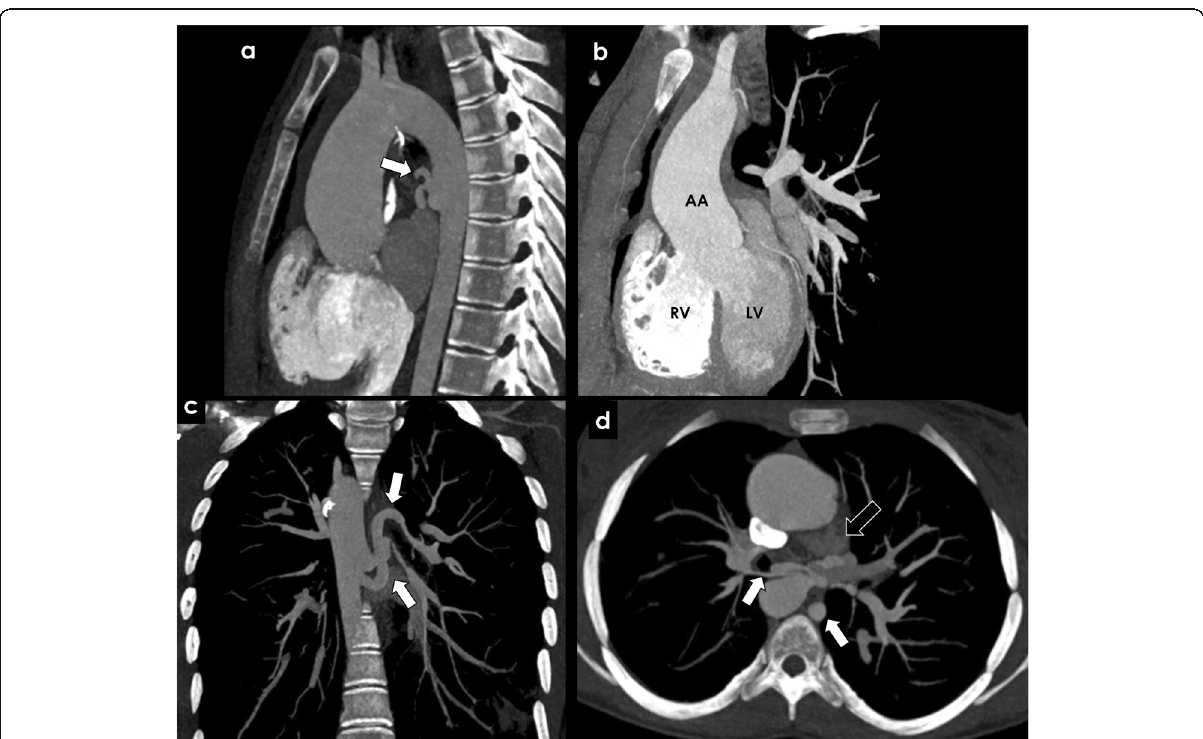
Fig. 4 Congenital causes of BAH — Tetralogy of Fallot and pulmonary agenesis. Significant bronchial artery hypertrophy (white arrows) in a patient with tetralogy of Fallot ( a – c ) and in a patient with pulmonary artery agenesis ( d ) —“ image b ” shows a ventricular septal defect, overriding aorta and right ventricular hypertrophy, features of tetralogy of Fallot. The black arrow in “ image d ” depicts the absence of the pulmonary artery. RV, right ventricle; LV, left ventricle; AA, ascending